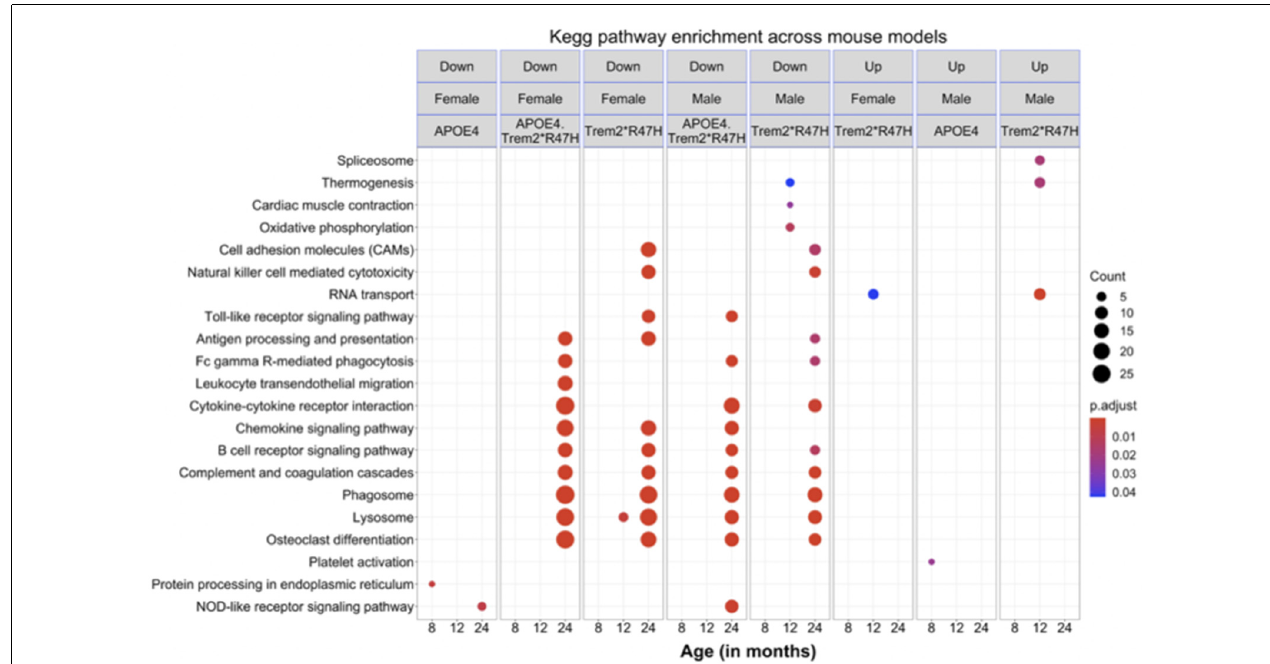
FIGURE 7 | KEGG pathways enrichment analysis. Significantly enriched KEGG pathways ( p < 0.05) in the downregulated and upregulated list of genes across mouse models at different ages for both sexes. All alleles expressed were